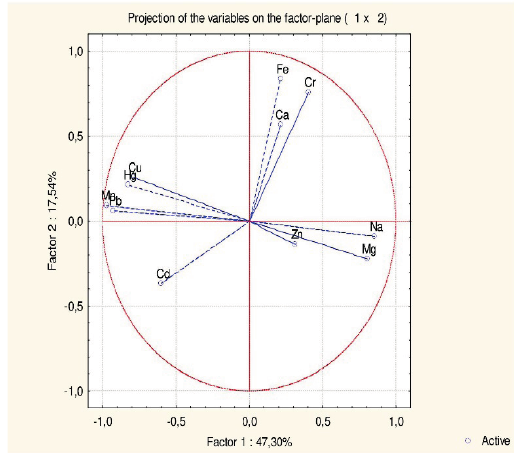
Figure 4: Projections of variables in PCA.